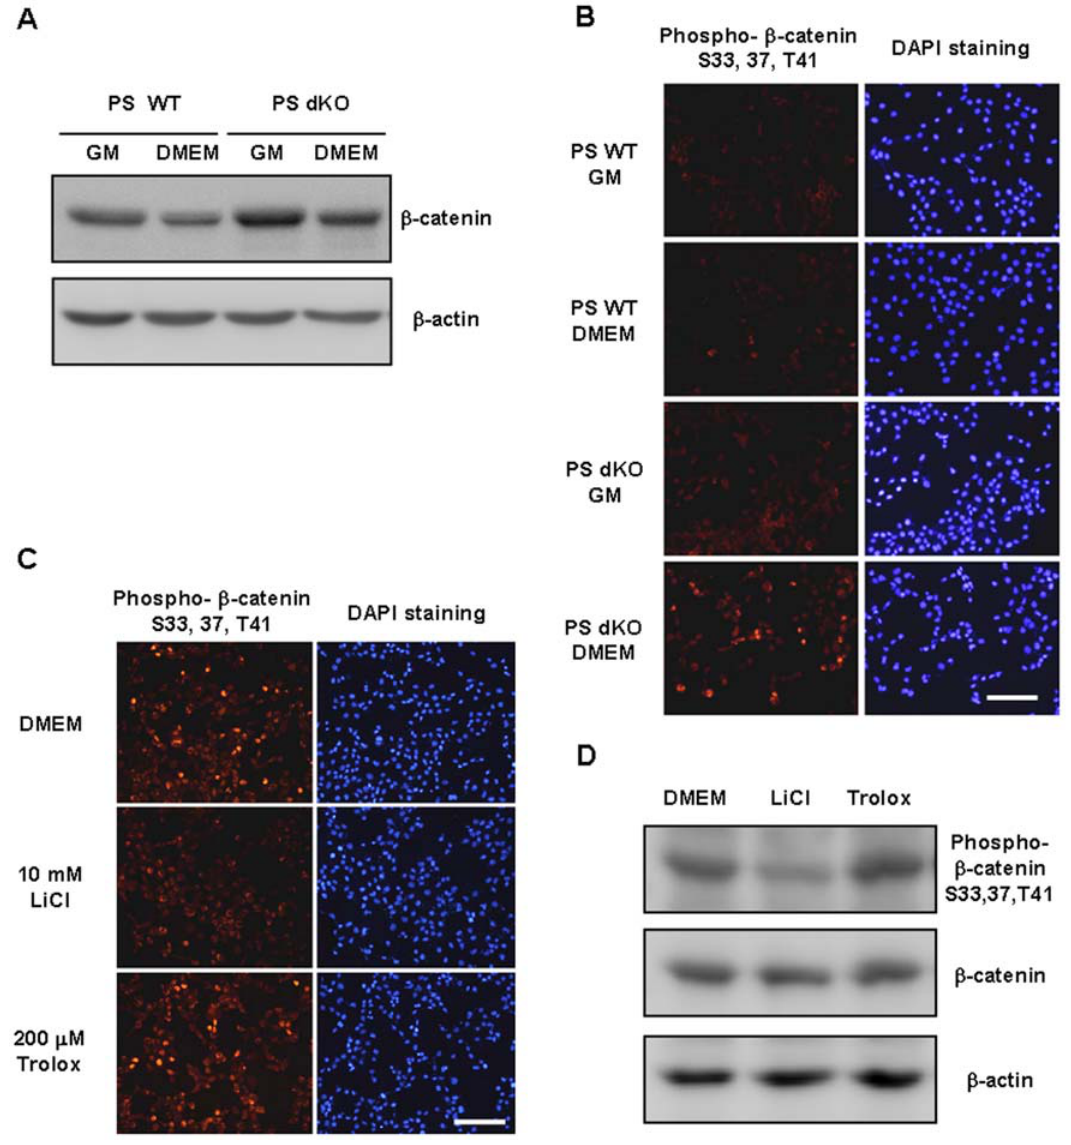
Figure 3. Phospho- b -catenin was accumulated in PS dKO MEFs under serum deprivation conditions. (A) b -catenin was accumulated in PS dKO MEFs, not in PS WT under normal and serum deprivation conditions. b -actin served as a loading control. (B) PS WT and PS dKO MEFs were incubated in growth media or DMEM for 30 hr, followed by immunofluorescent staining. PS dKO MEFs in DMEM labeled more brightly against anti- phospho- b -catenin (S33, 37, T41) antibody. The white bar represents 200 m m. (C) PS dKO MEFs were incubated w/wo 10 mM LiCl or 200 m M trolox in DMEM for 30 hr and labeled with phospho- b -catenin (S33, 37, T41)-specific antibody (Red). Many cells contained phosphorylated forms of b -catenin in DMEM- and trolox-treated PS dKO MEFs by fluorescence microscopy. But, LiCl-treated PS dKO MEFs stained weakly. DAPI staining was used to visualize cell nuclei (Blue). The white bar represents 200 m m. (D) Western blot analysis showed that LiCl effectively decreased phosphorylation of b - catenin at the S33, 37, and T41 sites without altering total b -catenin or b -actin levels. However, trolox-treated cells showed similar levels of phospho- b -catenin compared with DMEM alone.